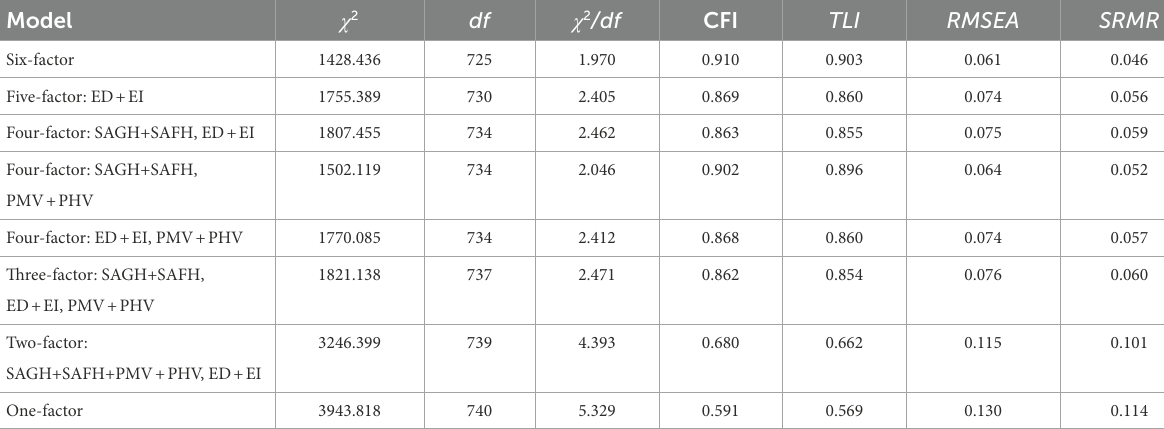
TABLE 1 Results of confirmatory factor analysis.